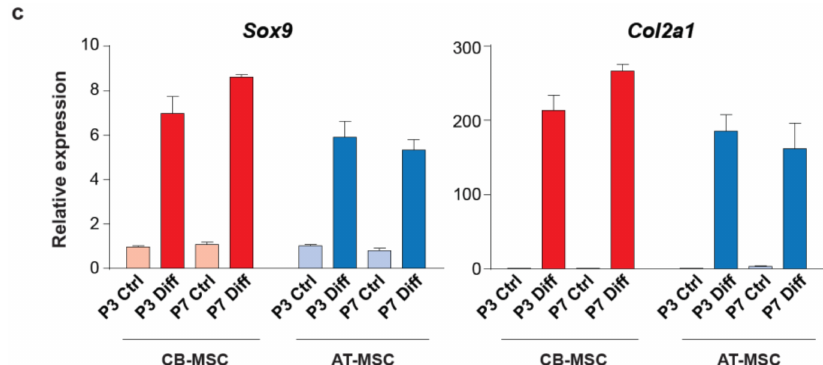
Figure 5. Expression of lineage marker genes in the di ff erentiated MSCs. ( a ) Osteogenic markers, Ocn and Opn , ( b ) adipogenic markers, Adipoq and Pparg , and ( c ) chondrogenic markers, Sox9 and Col2a1 , were used to determine the multi-lineage di ff erentiation of AT-MSCs and CB-MSCs. MSCs cultured in basic medium without di ff erentiation agents for the same period of time were served as controls. Gene expressions were normalized with housekeeping gene Gapdh . Experiments were performed with three replicates. Data represent mean ± SD; * p < 0.05 and ** p <